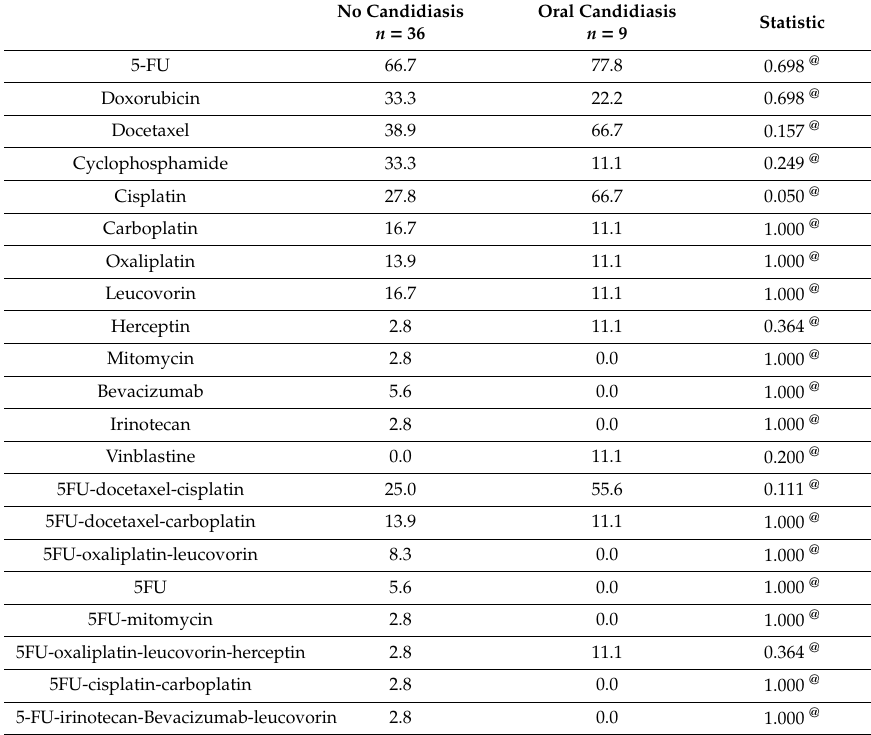
Table 2. Medications received during the cycle according to candidiasis